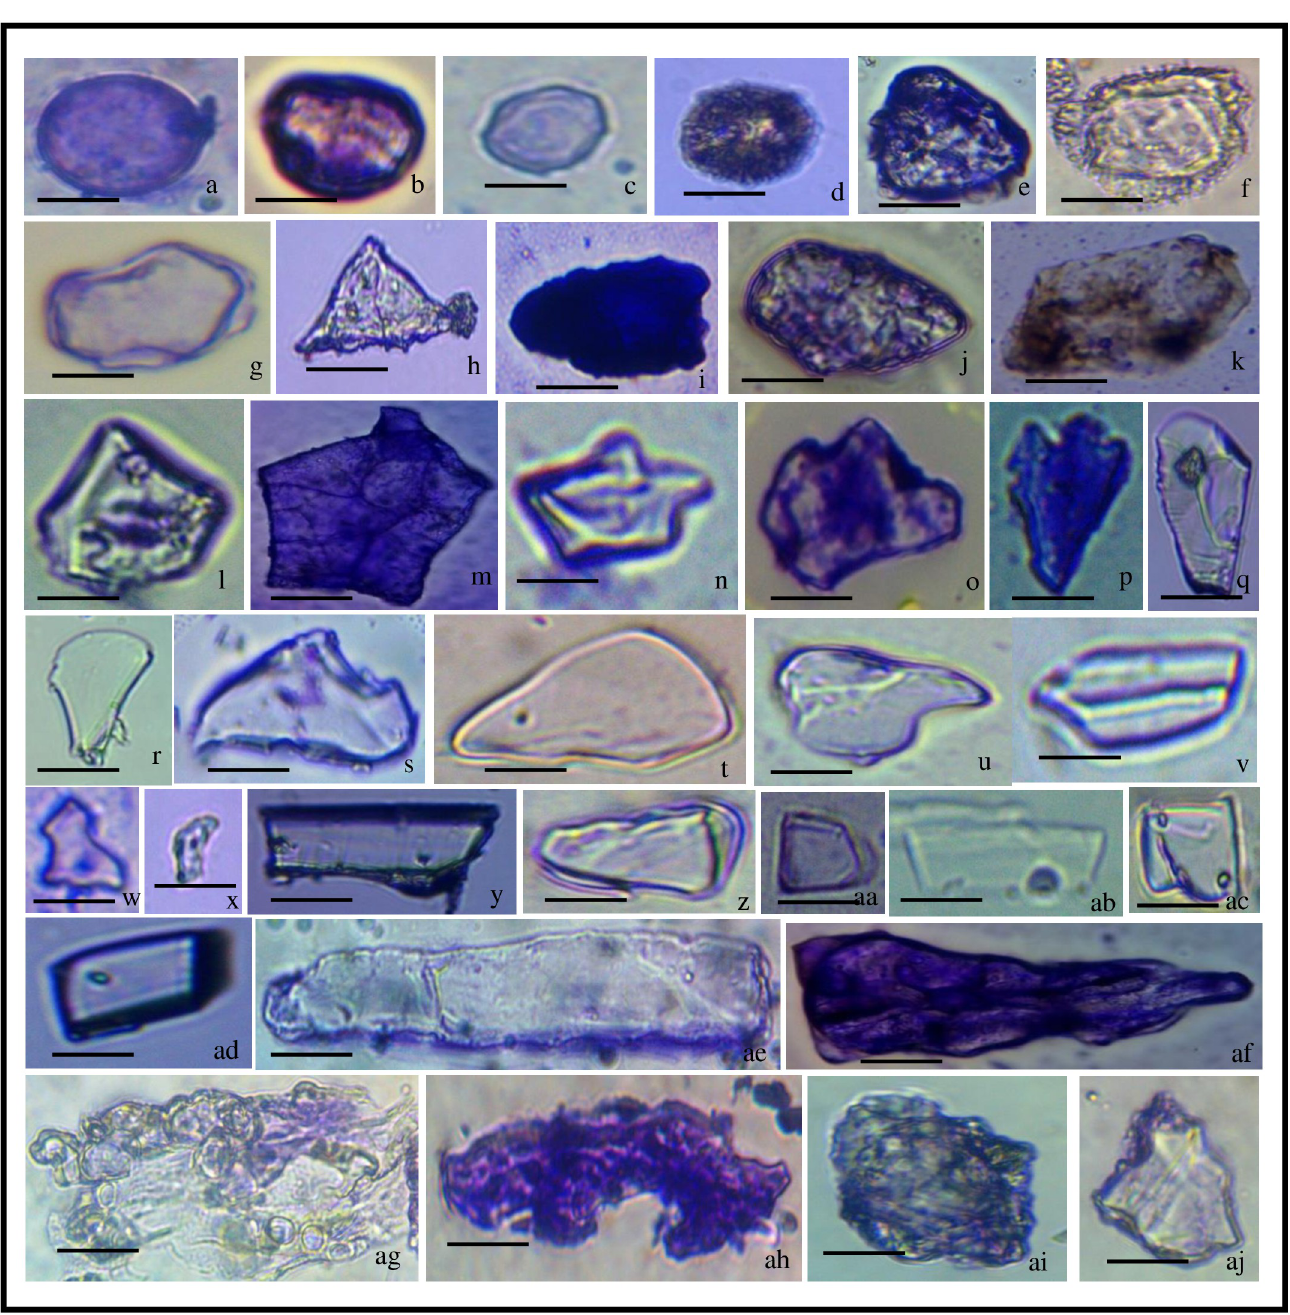
Fig 4. Phytolith morphotypes of Acrachne racemosa (Heyne ex Roem. & Schult.) Ohwi (Culm). Globular psilate (a, b); Globular granular (c, d); Globular echinate (e, f); Globular polyhedral (g); Triangular (h); Ovate (i); Polyhedral (j); Pentagon (k, l); Polyhedral (m); Stellate (n); Cuneiform bulliform (o-r); Cavate (s); Cuneiform (t); Acute bulbous (u); Trapezoid (v); Horned tower (w, x), Long trapezoid (y, ab); Tabular simple (z); Trapezoid (aa); Cuboid (ac, ad); Smooth elongate (ae); Elongate irregular (af); Nodular (ag); Amoeboid (ah); Blocky irregular (ai); Blocky polyhedral (aj) bar = 20 μ m. https://doi.org/10.1371/journal.pone.0263721.g004 6e), cavate (Fig 6f), tabular simple (Fig 6g and 6h), long trapezoids (Fig 6i), trapezoid (Fig 6j), polyhedral (Fig 6k, 6m and 6n), tabular polyhedral (Fig 6o and 6p), and acute (Fig 6w and 6x) were the morphotypes reported in this part. Trapezoids are also reported from the inflores- cence of Pennisetum by [111].